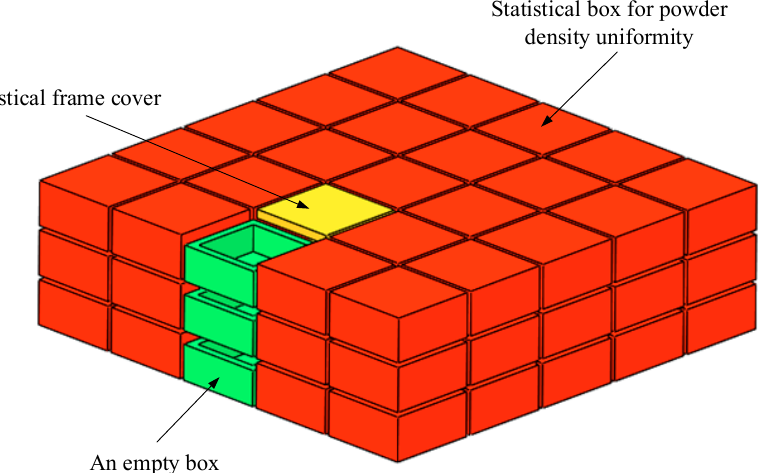
Figure 7. Sketch of the powder quality inspection design in the formation area.